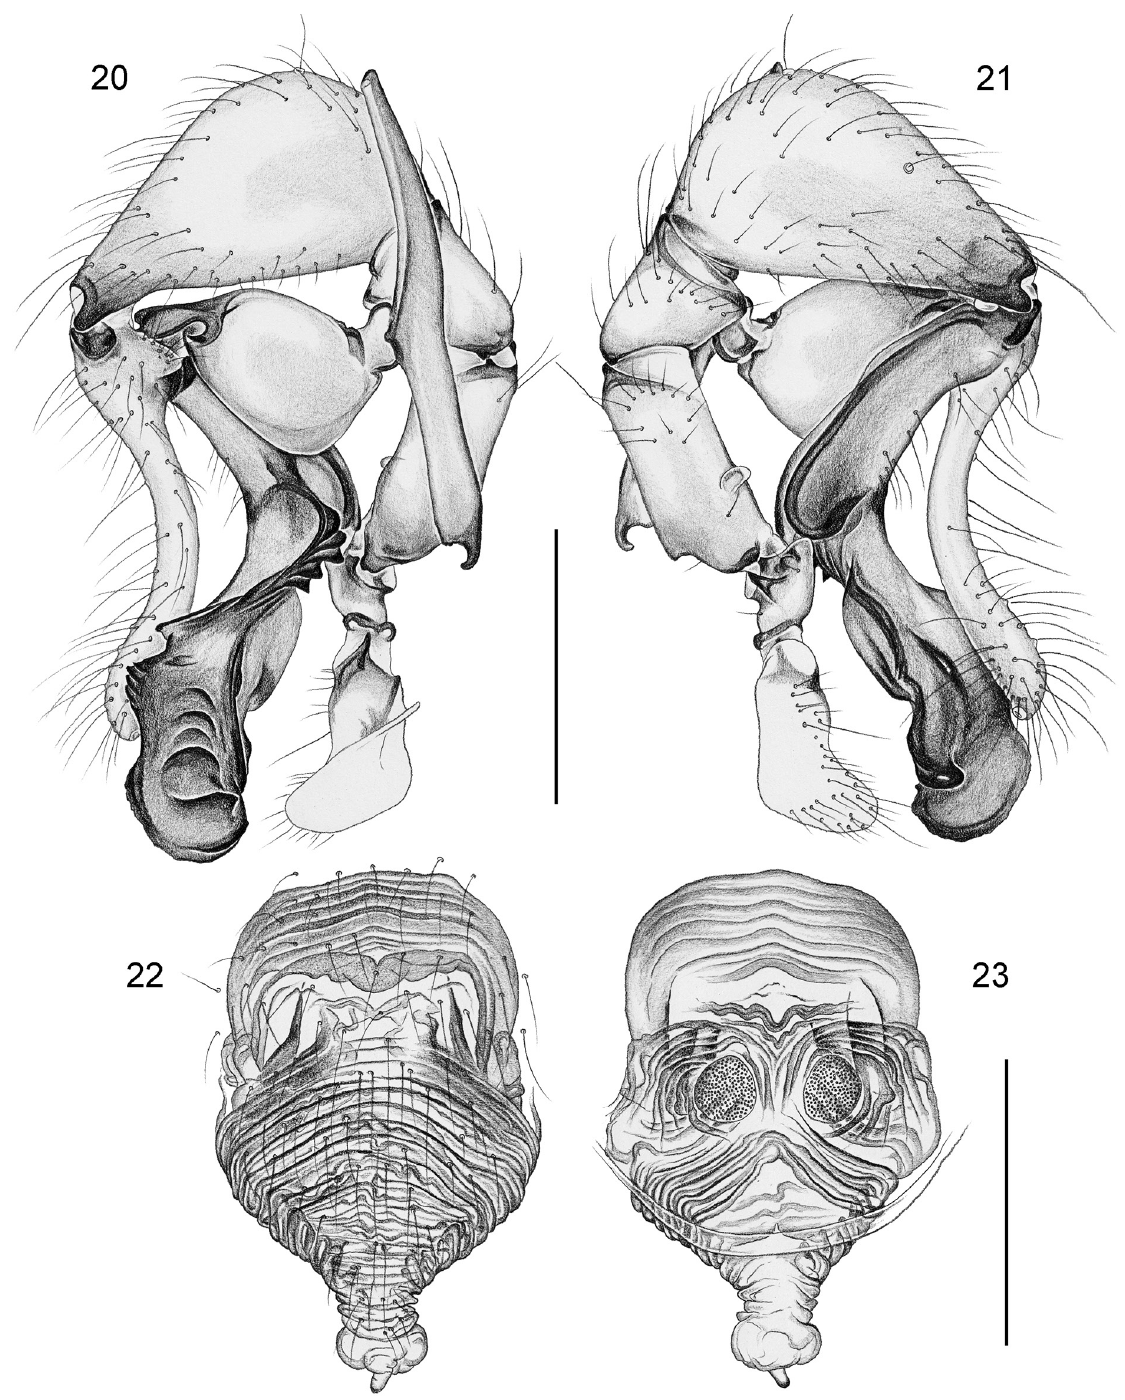
Figs 20–23. Panjange malagos Huber sp. nov. (ZFMK, Ar 12999). 20–21 . Right male palp, prolateral and retrolateral views. 22–23 . Cleared female genitalia, ventral and dorsal views. Scale bars = 0.5